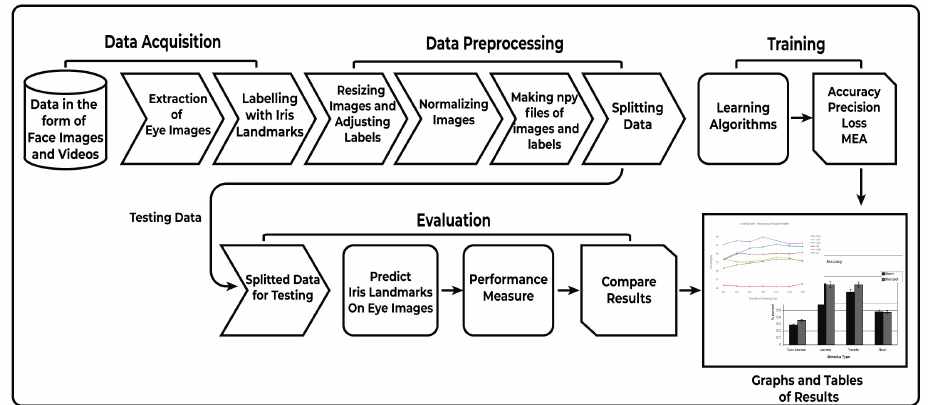
Figure 2. The flow of the proposed model.